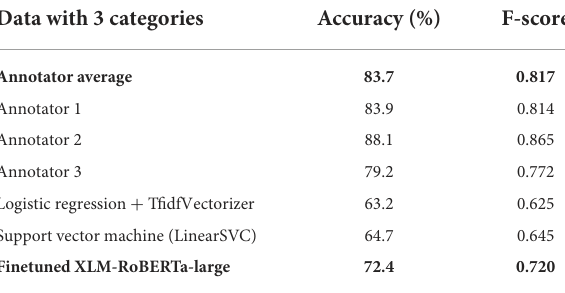
TABLE 5 Accuracy and F-scores by training dataset and testing dataset using the fine-tuned XLM-RoBERTa-large